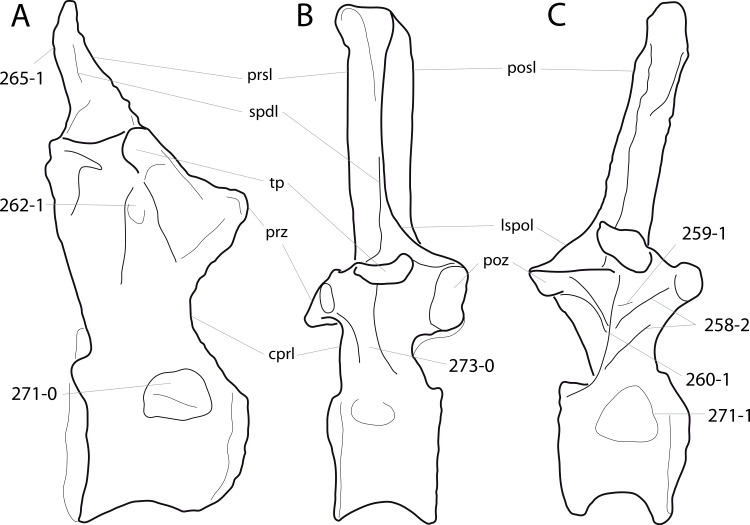
Neosauropod posterior dorsal vertebrae.Posterior dorsal vertebrae of Giraffatitan brancai MB.R.3822 (A), Apatosaurus louisae CM 3018 (B; traced from Gilmore, 1936), and Diplodocus carnegii CM 84 (C; traced from Hatcher, 1901) in right lateral view. Note the double pcpl (C; C258-2), the accessory lamina in the parapophyseal centrodiapophyseal fossa (C; C259-1), the accessory lamina connecting the hyposphene with the pcdl (C; C260-1), the infradiapophyseal pneumatic foramen (A; C262-1), the dorsally tapering neural spine (A; C265-1), the different shapes of the pleurocoels (C271), and the ventrally open parapophyseal, centrodiapophyseal fossa (B; C273-0). Abb.: cprl, centroprezygapophyseal lamina; lspol, lateral spinopostzygapophyseal lamina; posl, postspinal lamina; poz, postzygapophysis; prsl, prespinal lamina; prz, prezygapophysis; spdl, spinodiapophyseal lamina; tp, transverse process. Scaled to same total height.